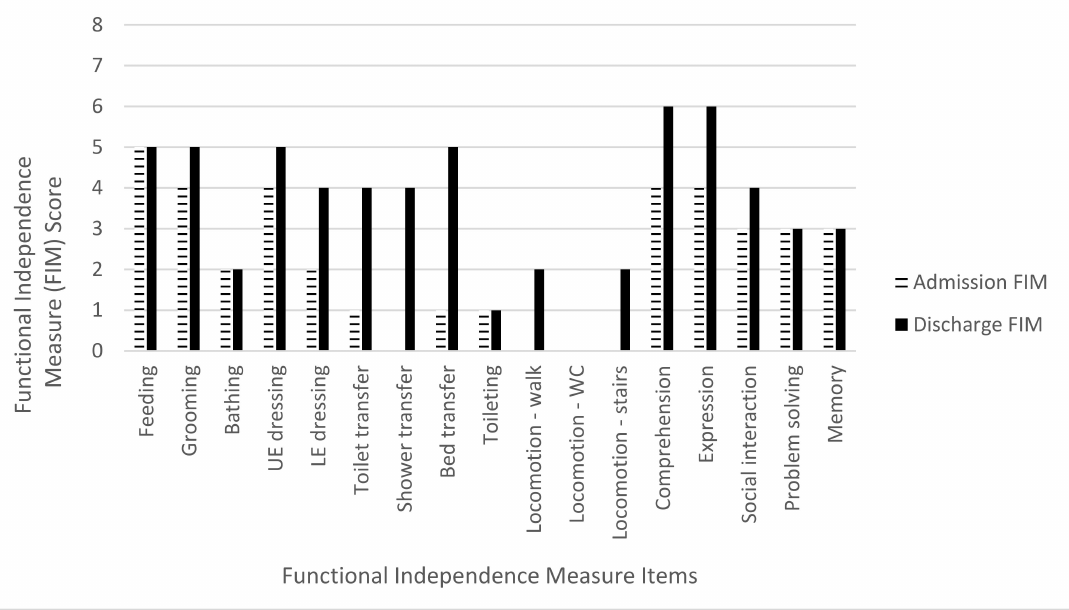
Figure 5. Subject 4 admission and discharge functional independence measure